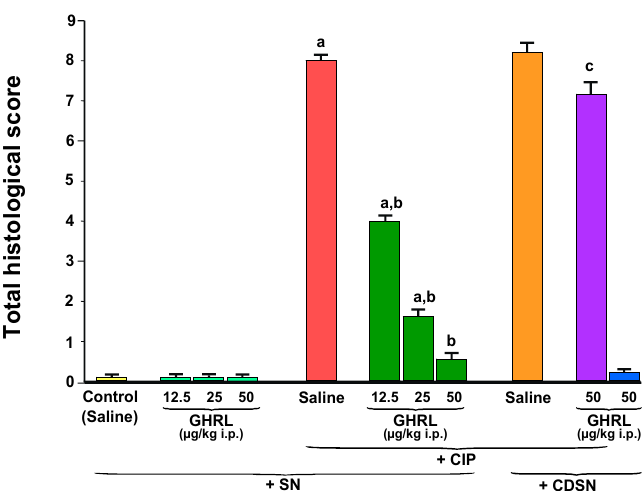
Figure 3. Effect of saline or ghrelin (GHRL) given intraperitoneally at a dose of 12.5, 25 or 50 μ g/kg and cerulein-induced pancreatitis (CIP) on total histological score in sensory nerves-intact rats (SN) or rats with capsaicin deactivation of sensory nerves (CDSN). a p < 0.05 compared to the control group with intact sensory nerves and without induction of CIP; b p < 0.05 compared to sensory nerves-intact rats with CIP pretreated with saline; c p < 0.05 compared to sensory nerves-intact rats pretreated with GHRL at a dose of 50 μ g/kg prior to CIP. Mean ± SEM from values obtained from 10–15 rats in each experimental group. Table 1. Effect of saline or ghrelin (GHRL) given intraperitoneally at increasing doses of 12.5, 25 or 50 µ g/kg on morphological changes of pancreatic tissues in the course of cerulein-induced pancreatitis (CIP) in animals with intact sensory nerves or with capsaicin deactivation of sensory nerves. Groups